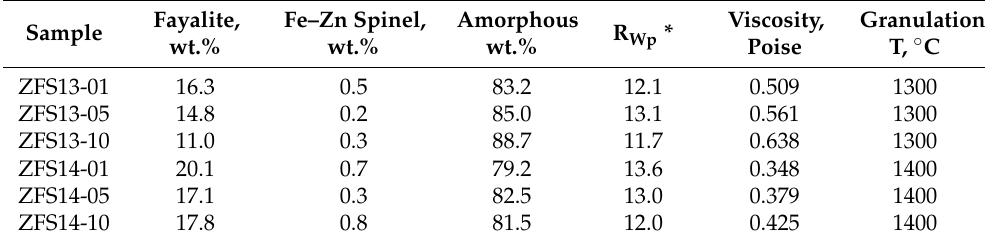
Table 3. Quantification of phases in the samples using Rietveld refinement and calculated viscosities at granulation temperatures using FactSage 8.1.